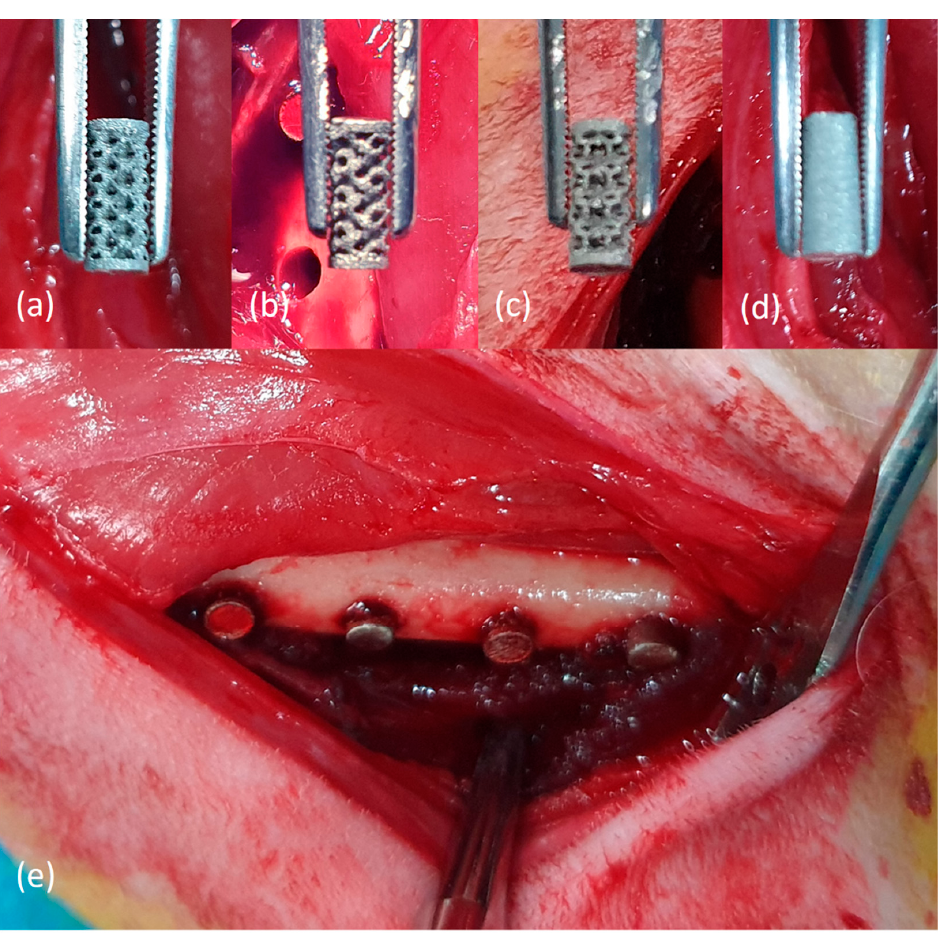
Figure 3. ( a – d ) Cylinder ‐ shaped highly porous 3D ‐ printed titanium specimens with four different pore designs (Octadens, Gyroid, Dode, and Solid (sham)). ( e ) Application and insertion of 3D ‐ printed titanium specimens onto the rabbit medial femur.